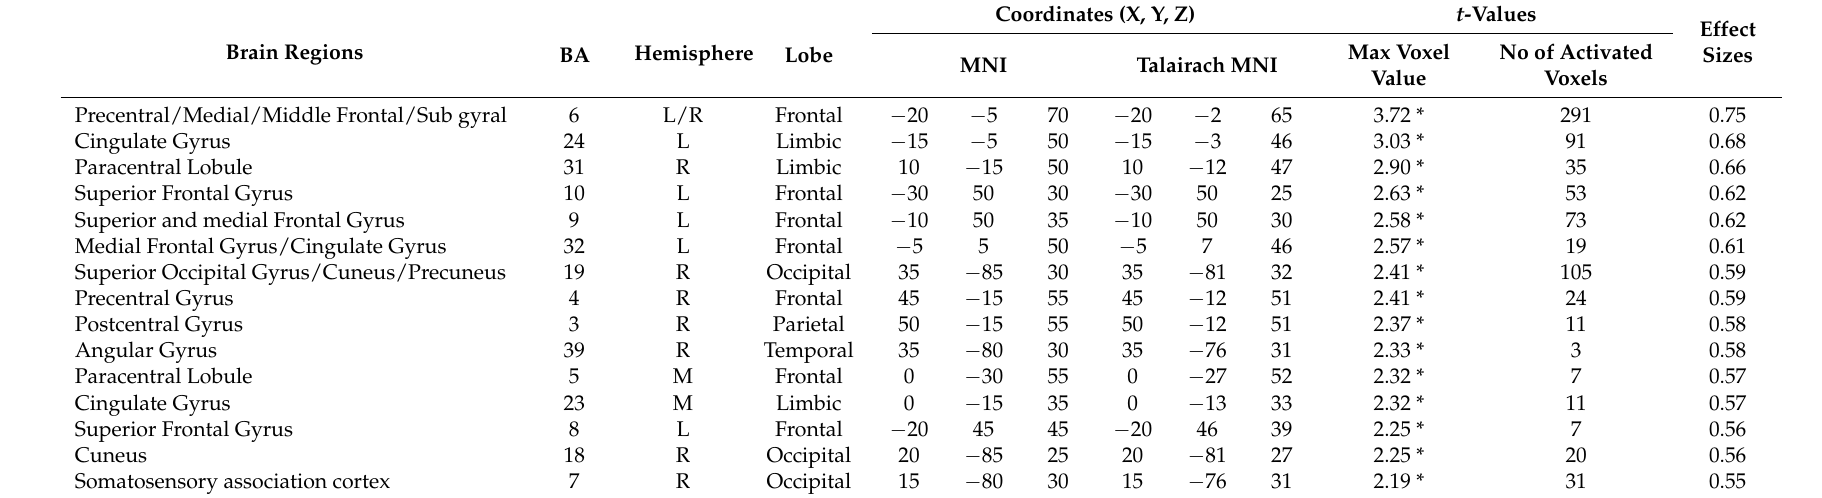
Table 2. Standardized low-resolution brain electromagnetic tomography (sLORETA) results of maximal brain electrical activity for the oddball effect (rare vs. frequent: 518 ms latency) for the TD